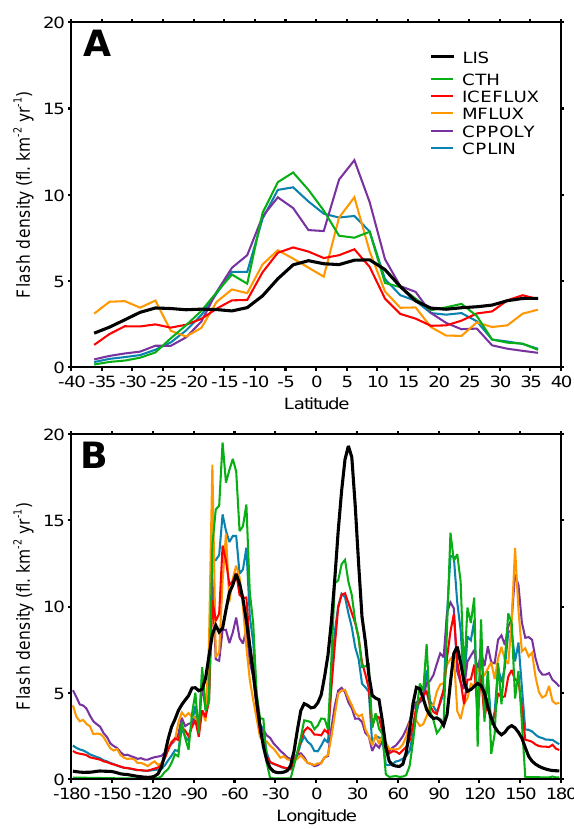
Figure 7. Five-year climatological (a) zonal and (b) meridional av- erage flash density distribution (2007–2011). The meridional aver- age is only taken within the LIS viewing region of ± 38 ◦ latitude. Results are shown for the LIS measurements and the five parametri- sations. Figure 8. Five-year climatological annual cycle of flash density for 2007–2011 for (a) , the northern region (0 ◦ –38 ◦ N) and (b) , the southern region (38 ◦ S–0 ◦ ). Results are shown for the LIS mea- surements and the five